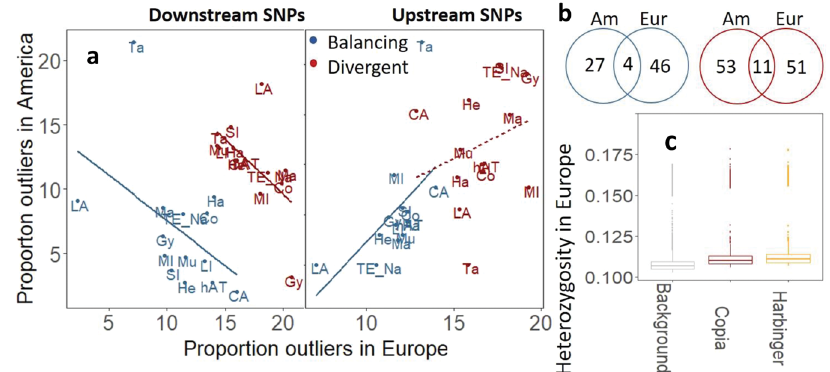
Fig. 5 | Signatures of selection across A. lyrata lineages. The proportion of outliers associated with TE superfamilies correlates between the two sampling areas ( a ), even though few SNPs shared signatures of selection between the two sampling areas ( b ). H 0 (background heterozygosity) is not signi fi cantly different from H TE (heterozygosity associated with Copia and Harbinger elements) across outcrossing European A. lyrata genomes ( c , Supplementary Data 9), con fi rming thattheeffectofCopiaandHarbingerelementsonnearbyheterozygosityislimited